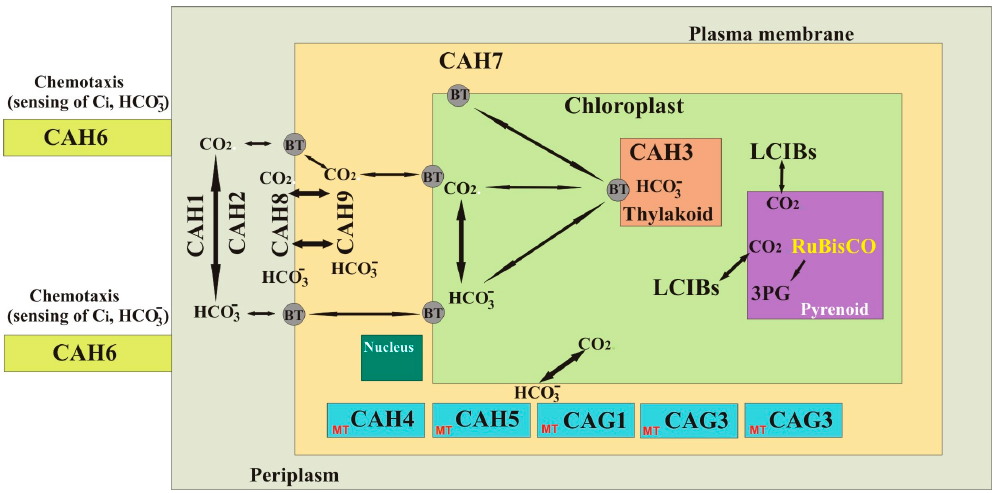
Figure 2. Schematic presentation of the C. reinhardtii model showing the roles of CAs in the cell and subcellular organelles. CAH1, CAH2, CAH3: α -Carbonic anhydrases; CAH4, CAH5, CAH6, CAH7, CAH8, and CAH9: β -Carbonic anhydrases; LCIB1, LICB2, and LCIB3: Low CO 2 -inducible proteins ( β -CAs); CAG1, CAG2, and CAG3: γ -Carbonic anhydrases; BT: Bicarbonate transporters; RuBisCO: Ribulose-1,5-bisphosphate carboxylase oxygenase; 3PG: 3-phosphoglycerate. MT: mitochondria.